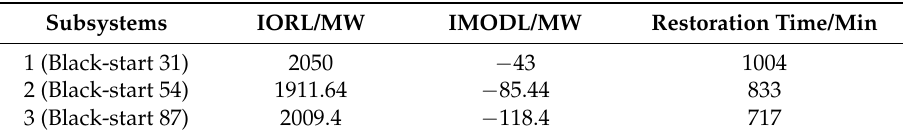
Table 4. The sectionalizing result in Scenario